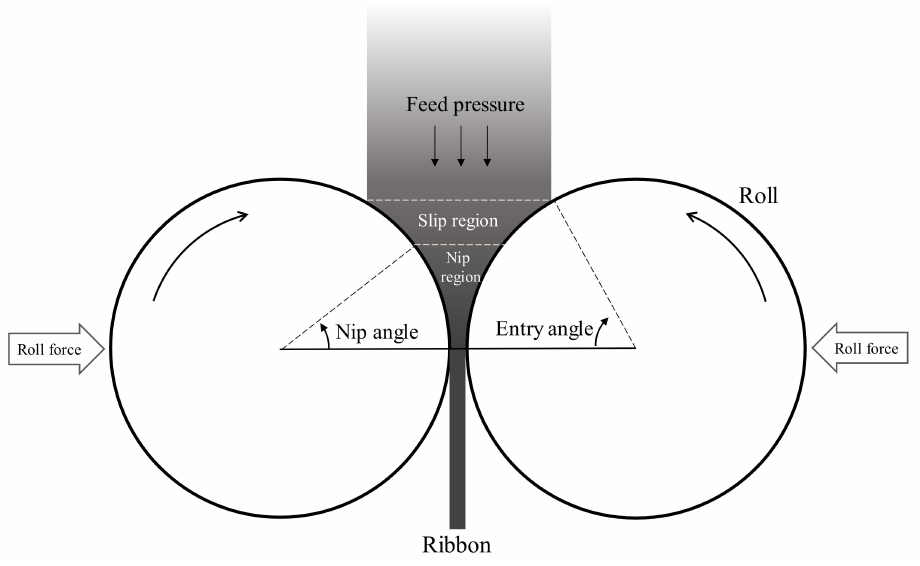
Figure 10. Schematic of the roller compaction